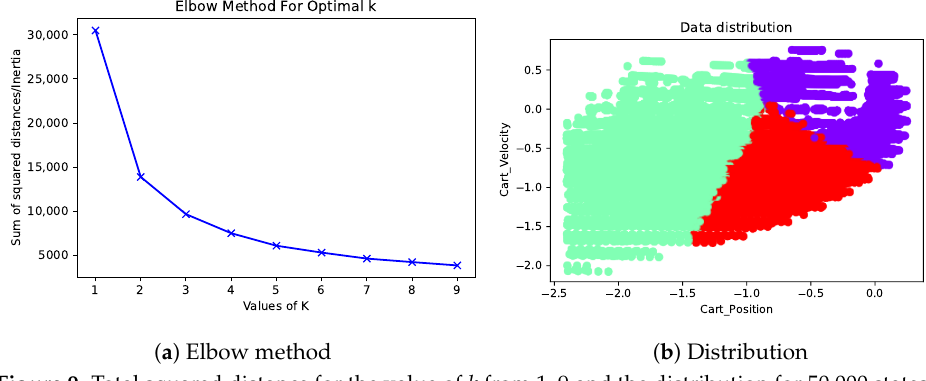
Figure 9. Total squared distance for the value of k from 1–9 and the distribution for 50,000 states with a value of k = 3 for the cart position and cart velocity attributes.